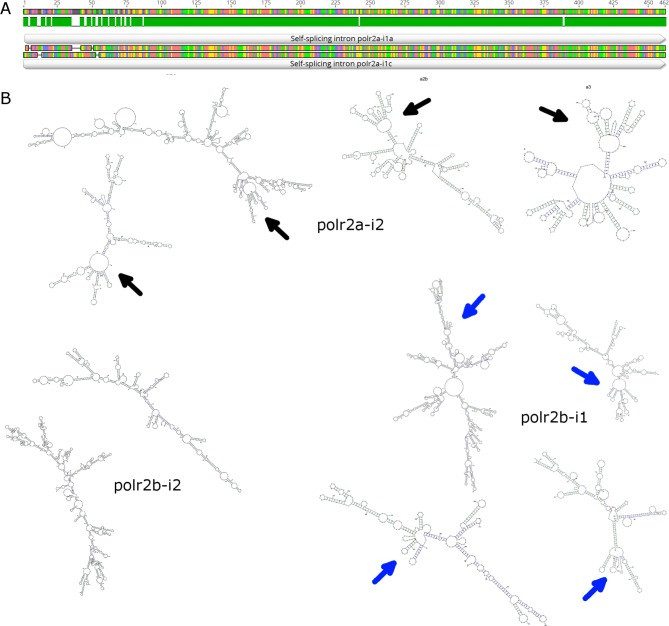
Self-splicing group 1 introns found in BsV.A: DNA Sequence alignment of recently duplicated self-splicing group 1 introns polr2a-i1a and polr2a-i1c (94% DNA sequence ID). B: Secondary structure and conserved autocatalytic ribozyme centers of other polr encoded introns.